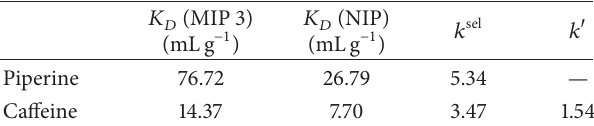
Table 2: The distribution ratio, selectivity coefficients, and relative selectivity coefficient of MIP 3 and